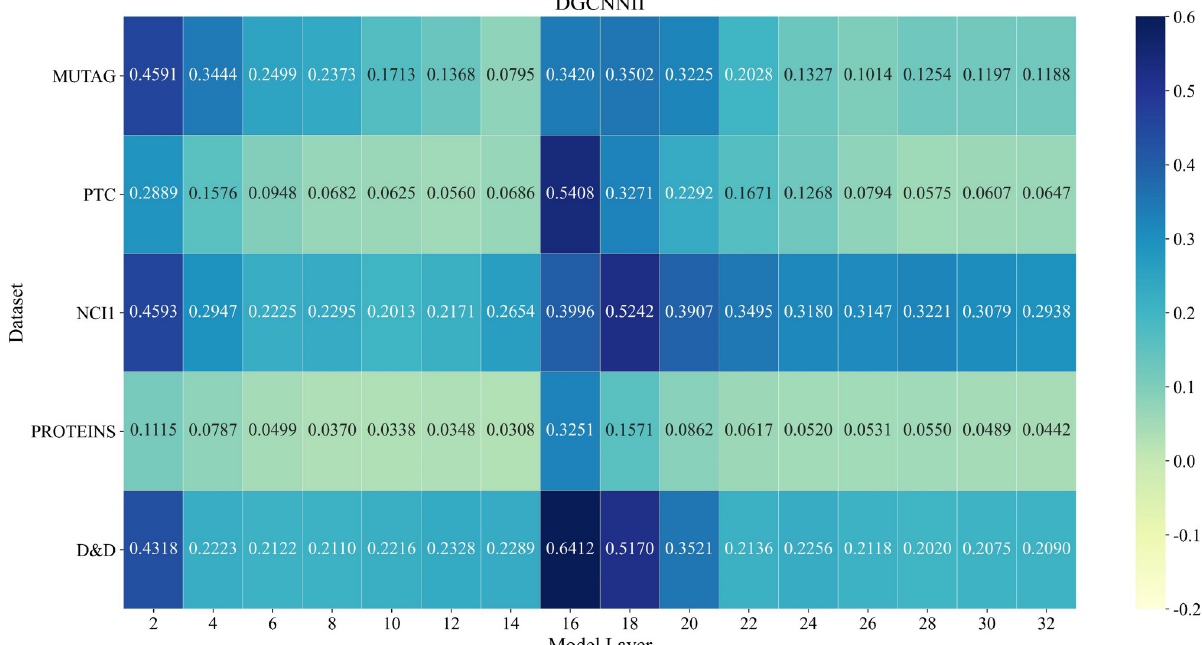
PLOS ONE | https://doi.org/10.1371/journal.pone.0279604 March 10,